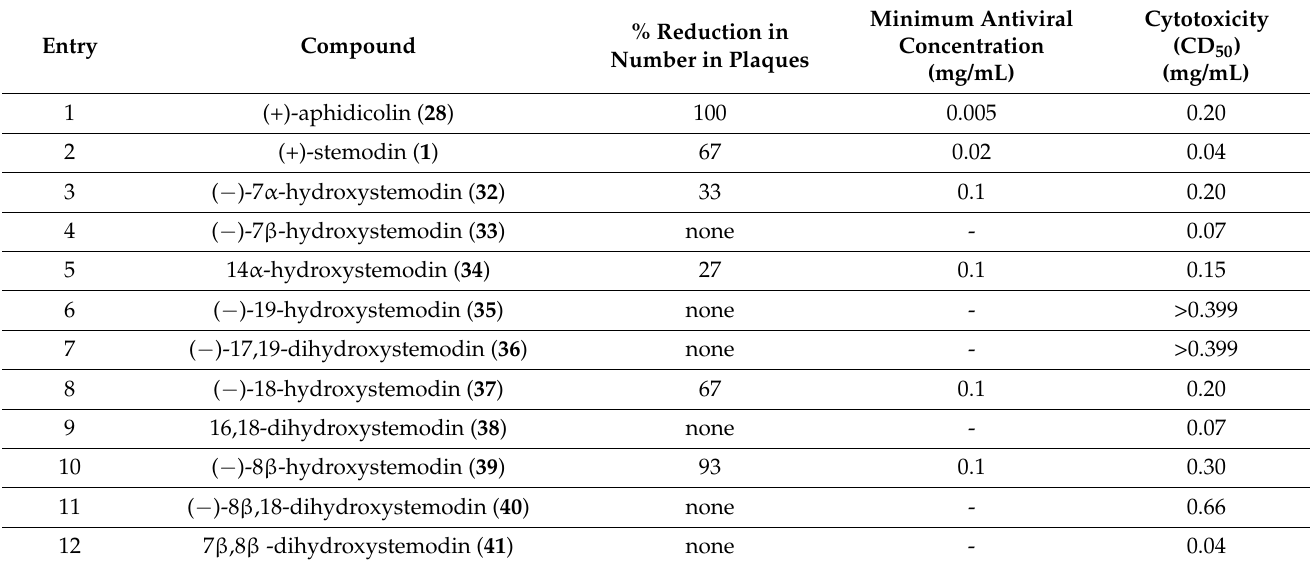
Table 6. Results of antiviral/cytotoxicity testing